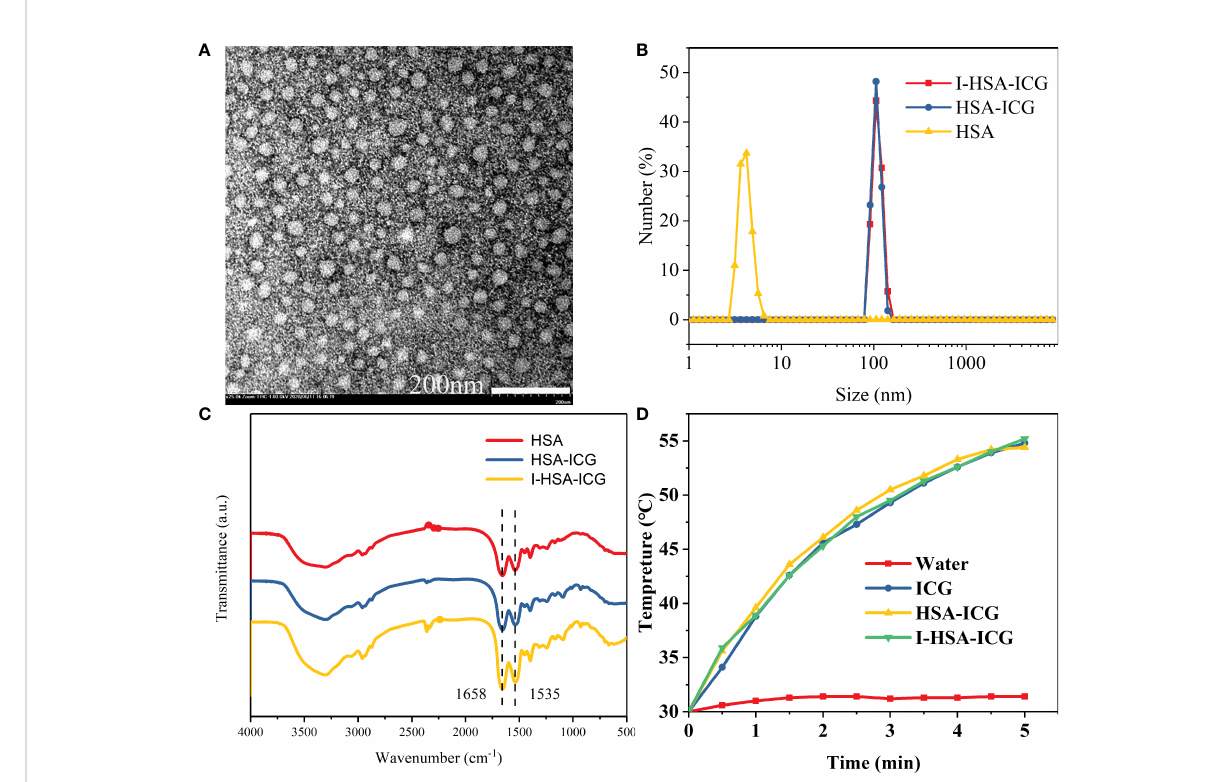
FIGURE 2 Characterization of I-HSA-ICG nanoparticles. (A) TEM image of I-HSA-ICG nanoparticles. Scale bars: 200nm. (B) Hydration diameter of HSA, HSA- ICG, and I-HSA-ICG in pure water. (C) FT-IR spectra of HSA, HSA-ICG, and I-HSA-ICG. (D) The photothermal heating curve after irradiating water and solutions of pure ICG, HSA-ICG, and I-HSA-ICG nanoparticles (C ICG = 0.1 mg/ml) with a power density of 2.0 W/cm 2 at 808 nm for 5 min. HSA, human serum albumin; ICG, indocyanine green; TEM, transmission electron microscope; FT-IR, Fourier